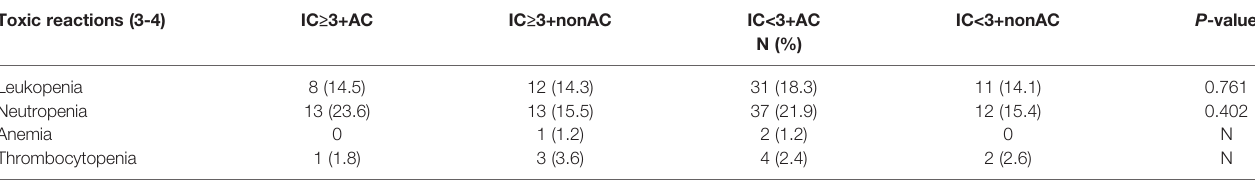
TABLE 5 | The toxic reactions among the four